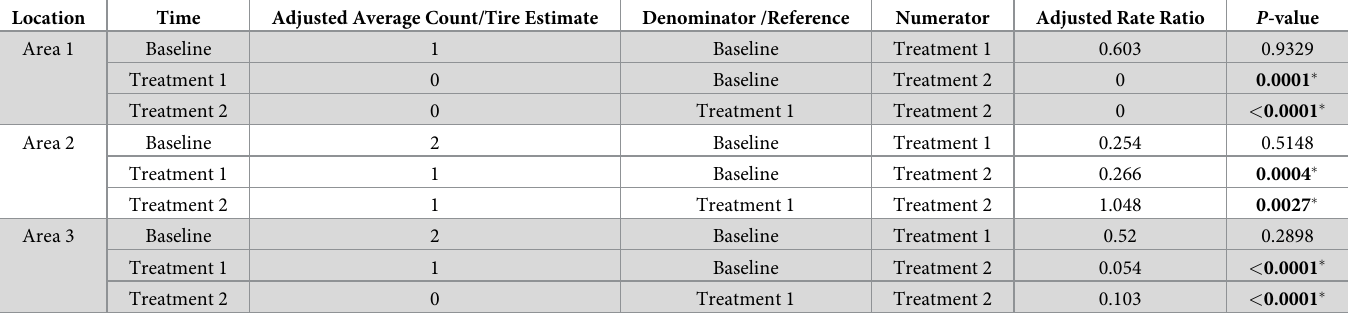
Table 5. Simple effect comparisons of median pupae Aedes aegypti densities per location per treatment using least squares means. Location